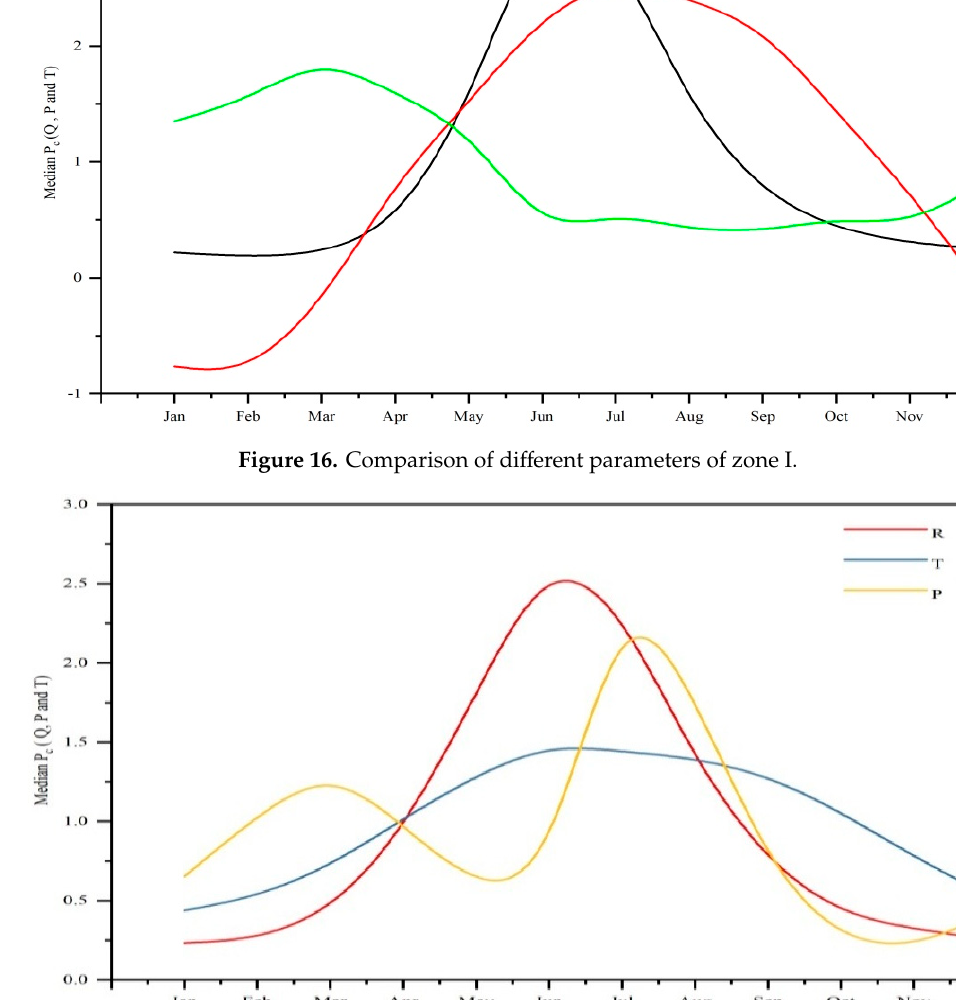
Figure 17. Comparison of different parameters of Zone II.